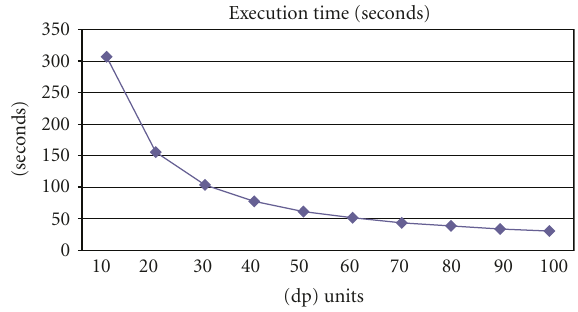
Figure 11: Execution time in seconds by number of parallel dp units to calculate 10 4